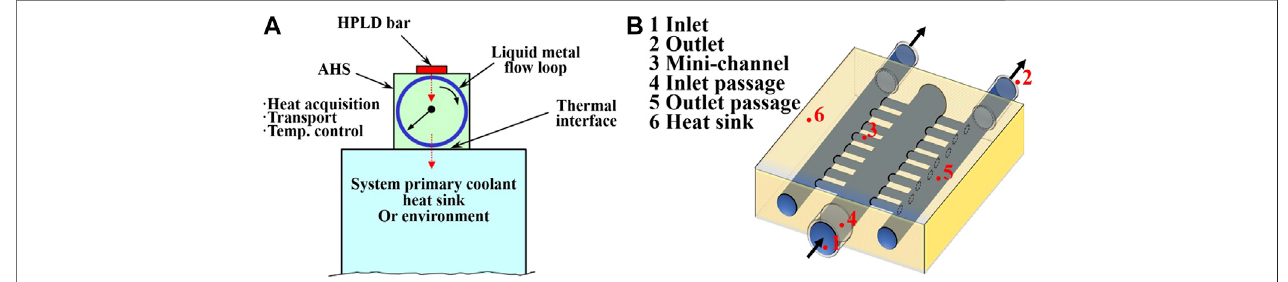
FIGURE13|(A) Liquidmetalheatdissipationsysteminwhichliquidaluminumalloyrotatesinaringtubetotakeawayheat.Adaptedfrom[57];Structureschematic of vascularized liquid metal heat sink. Adapted from [58].